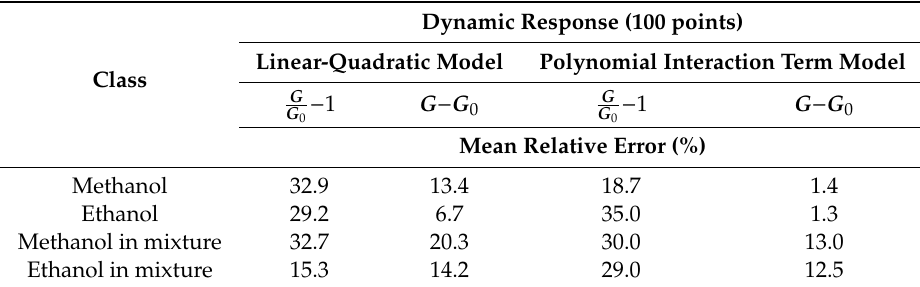
Table 3. Prediction results of the dynamic response with di ff erent variables.